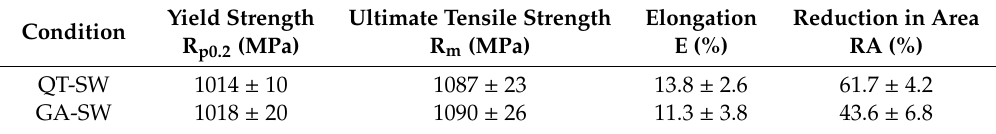
Figure 11. Probability density plot assuming Normal distribution of average elongations and area reduction and their uncertainties in Table 6 as mean and standard deviation values. ( a ) Plot for the DC Class 8.8 specimens. ( b ) Plot for the QT and GA Class 10.9 specimens. Table 7. Average values of the mechanical properties obtained in water submerged SSRT with 30MnB5 steel treated to class 10.9 bolt strength, both for naked and hot-dip galvanized specimens. Condition